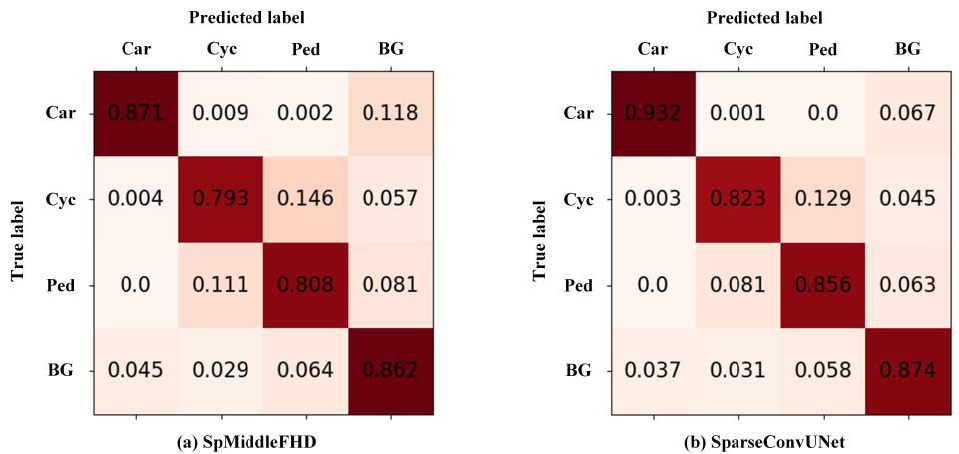
Figure 7. Confusion matrix. ( a ) shows the classification results of SpMiddleFHD. ( b ) shows the classification results of SparseConvUNet. The horizontal axis shows Predicted label, and the vertical axis shows True label. Each cell represents the prediction probability of the output. For darker colors, the prediction probability is larger. The main diagonal cell represents the probability of correct classification.